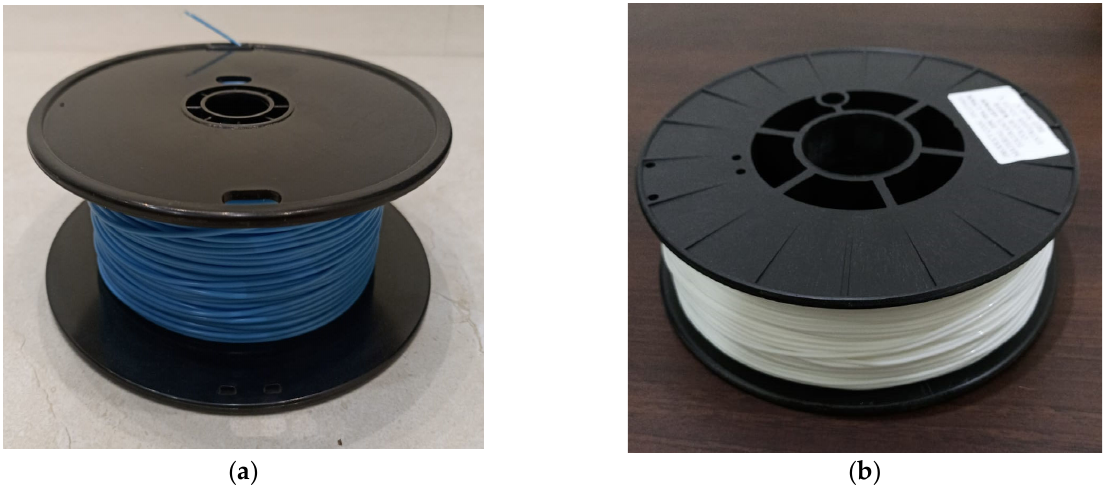
Figure 2. Feedstock filaments for FDM printing ( a ) ABS and ( b ) TPU. (TPU: ABS: TPU) combination of the specimen. Table 3 shows the specimen thickness ratio (T/T1) and T2 for ABS and TPU material.